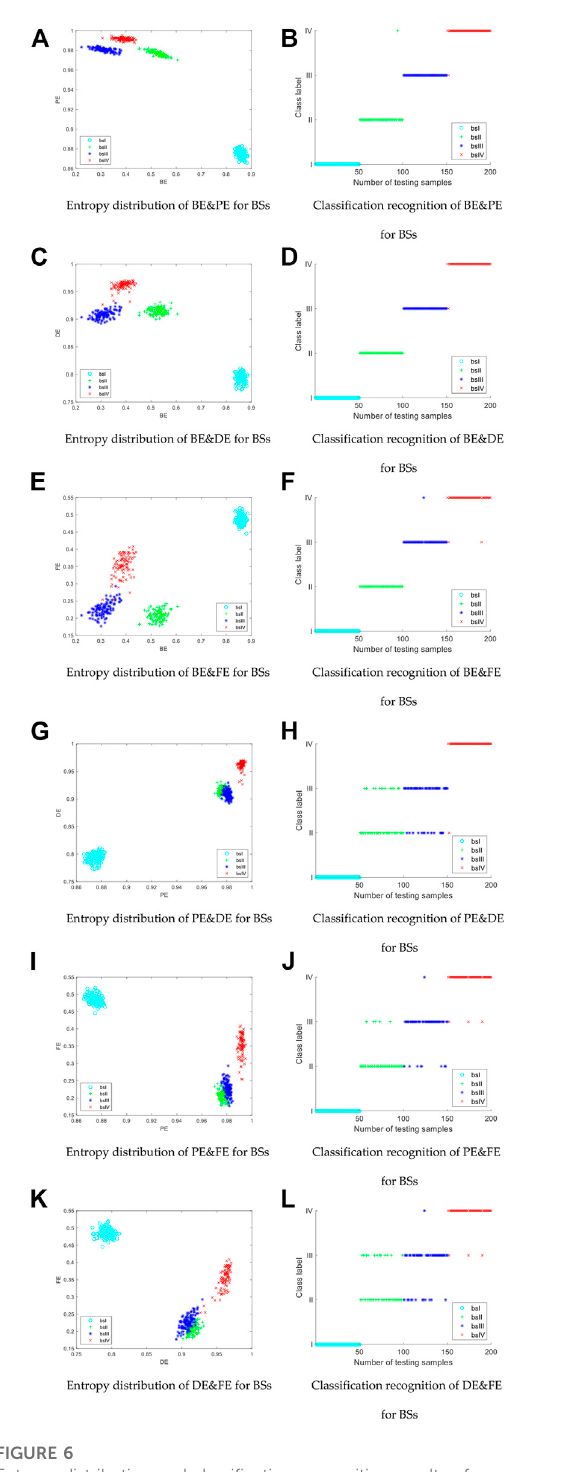
FIGURE 5 Entropy distribution and classi fi cation recognition results of BE&PE,BE&DE,BE&FE,PE&DE,PE&FE,andDE&FEofSSSs:distribution of different entropy combinations (Left column); classi fi cation recognition results (Right column).